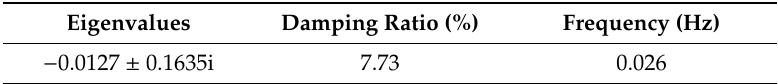
Table 2. The ultralow-frequency